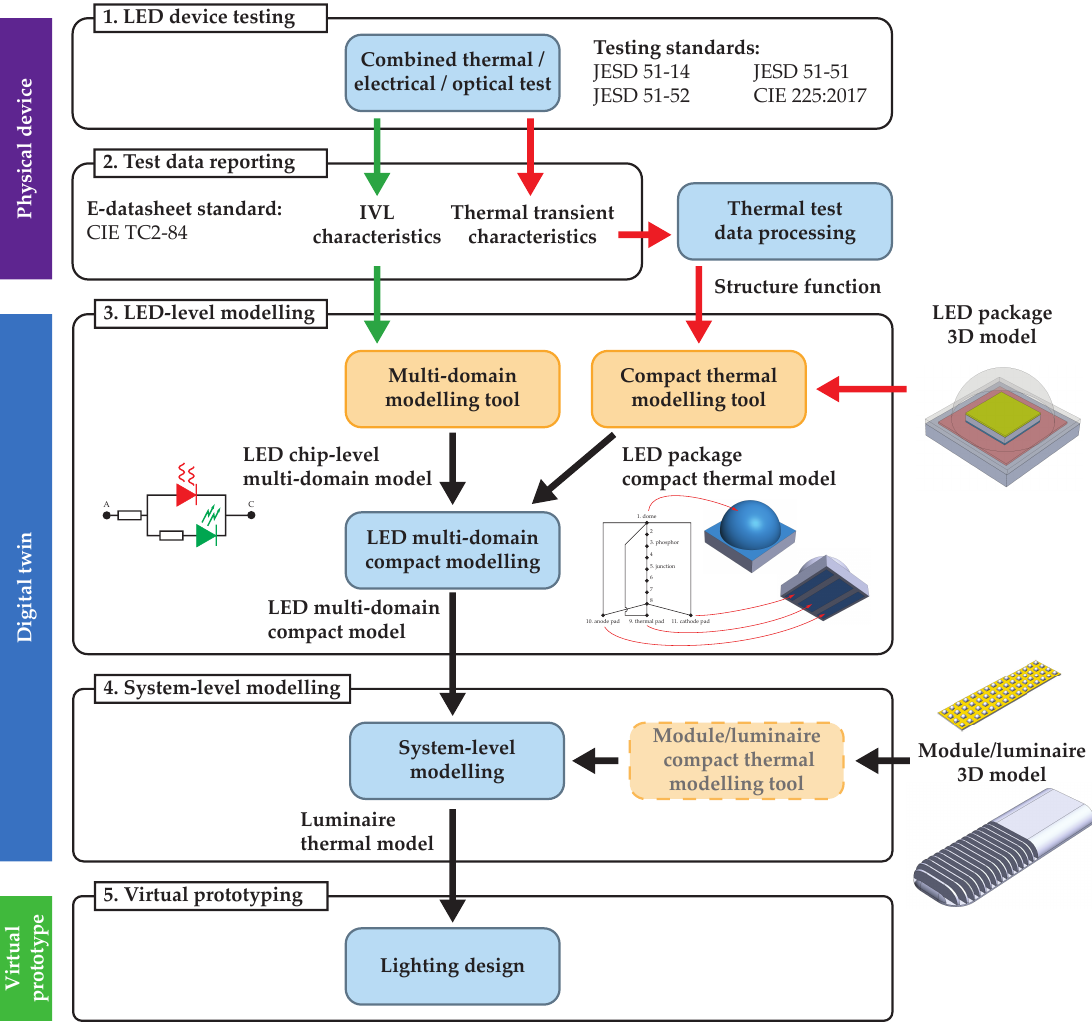
Figure 1. The Delphi4LED approach to creating and implementing LED digital twins (multi-domain compact models). The involved steps are indicated from top to bottom. Adapted from